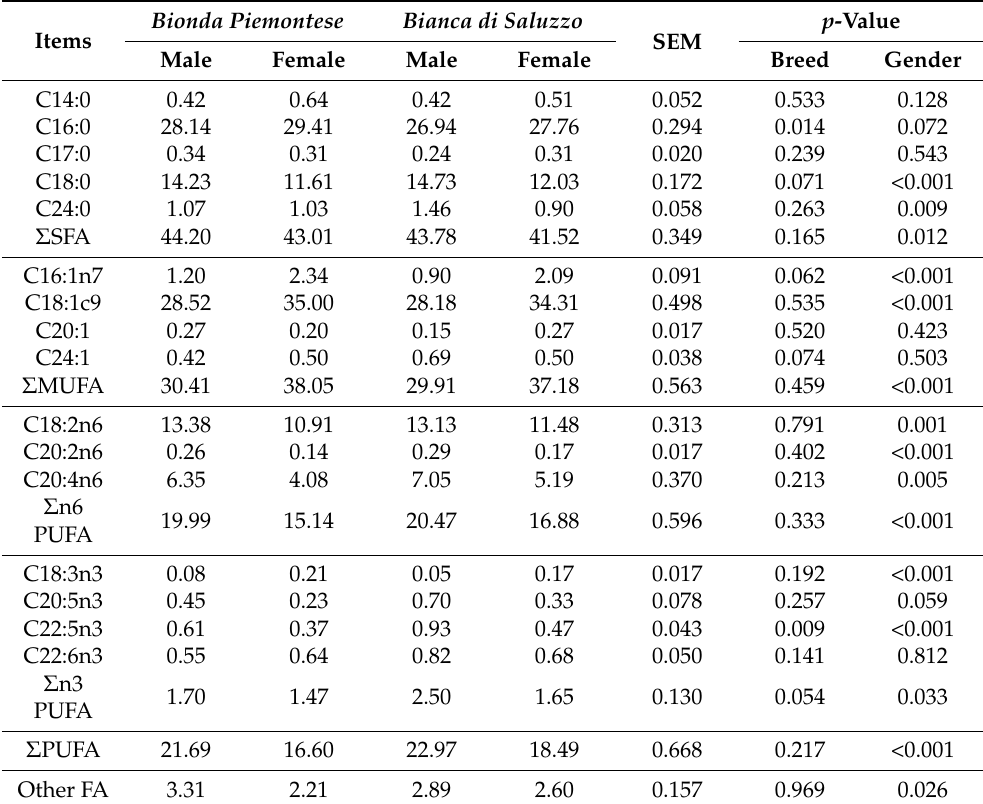
Table 6. Average fatty acid profile for breast meat (g/100 g of total detected fatty acids) of Bionda Piemotese and Bianca di Saluzzo breeds. Data are the average of the four-consecutive slaughtering at 5, 6, 7, and 8 months of age ( n =